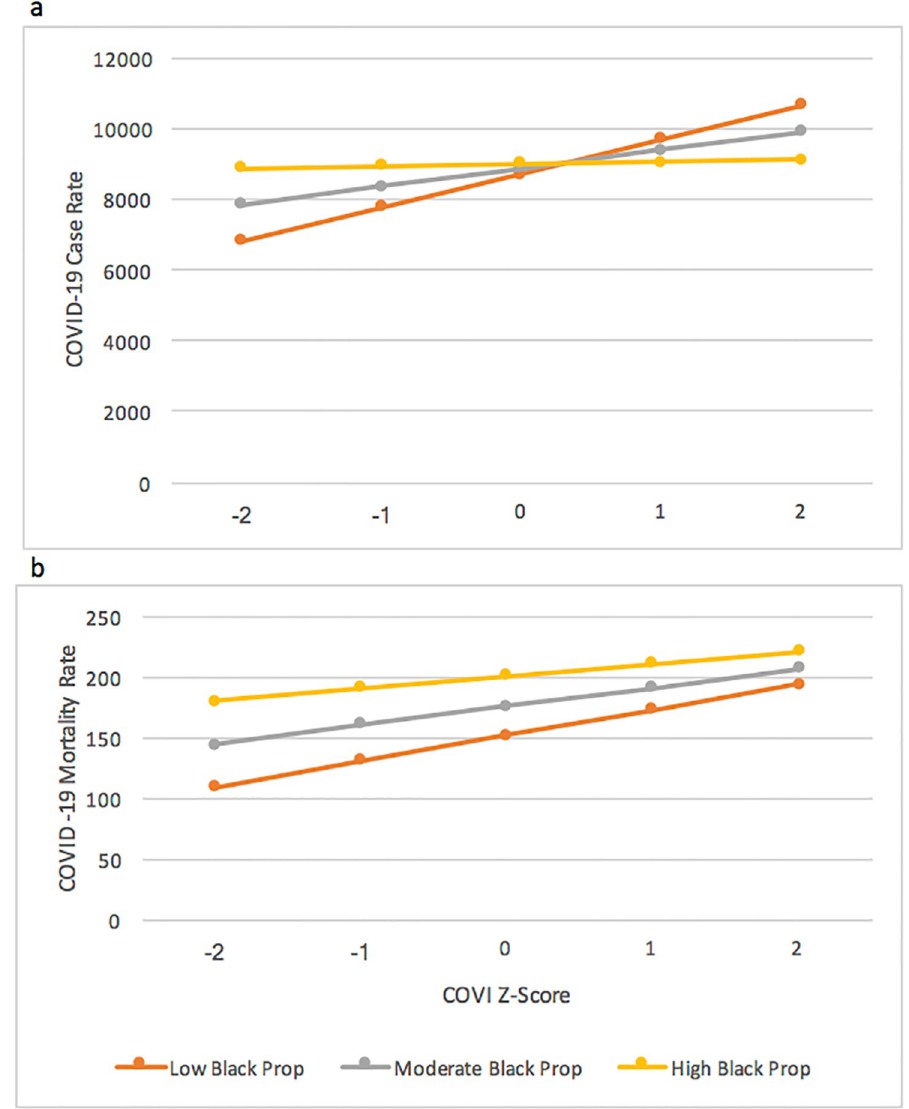
Fig 1. The relationship between Cost of Voting Index (COVI) z-score and COVID-19 outcomes across proportion of US county that is Black (n = 3,106 counties). a. The adjusted relationship between Cost of Voting Index (COVI) score and county COVID case rate by proportion Black. b. The adjusted relationship between Cost of Voting Index (COVI) score and county COVID mortality rate by proportion Black.